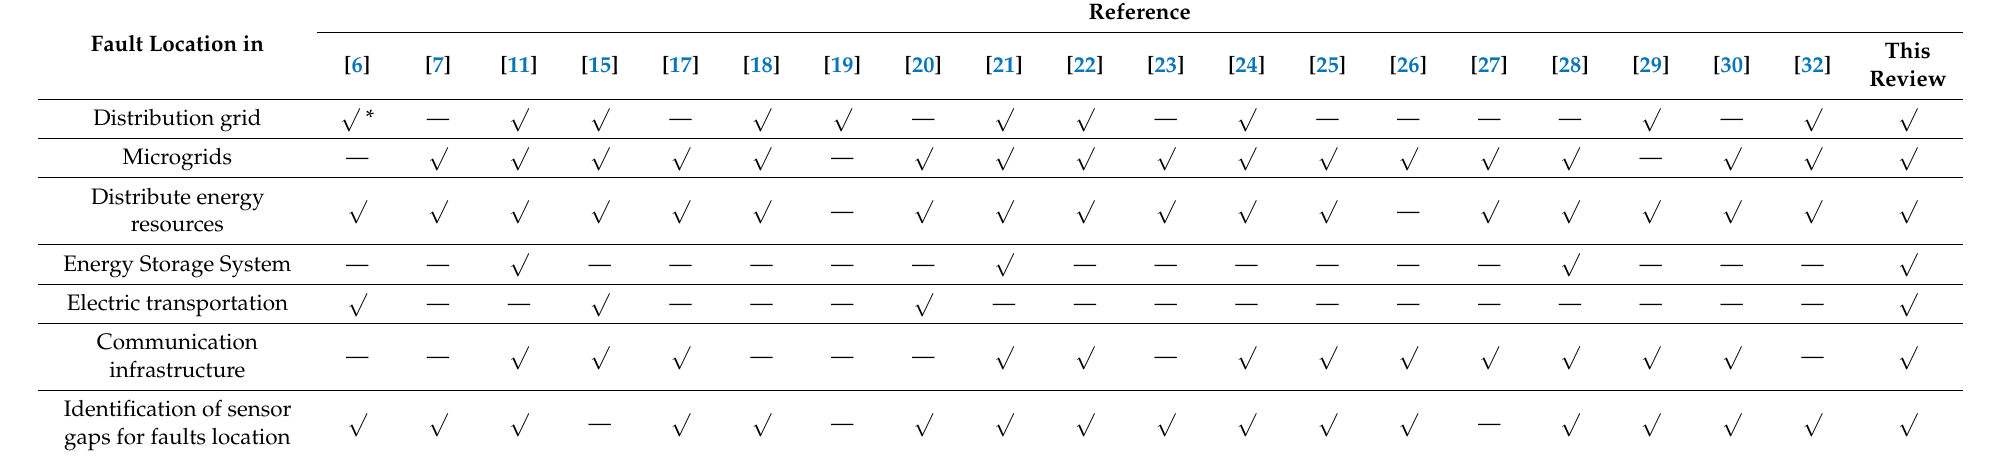
Table 1. Topics covered in this